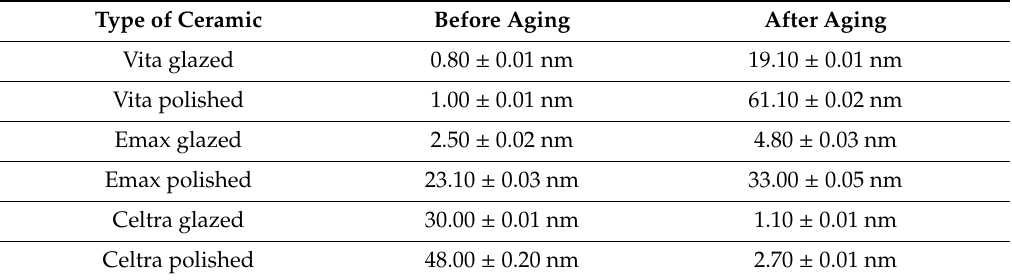
Table 7. Sa (nm) values for the three types of ceramics before and after thermocycling. Type of